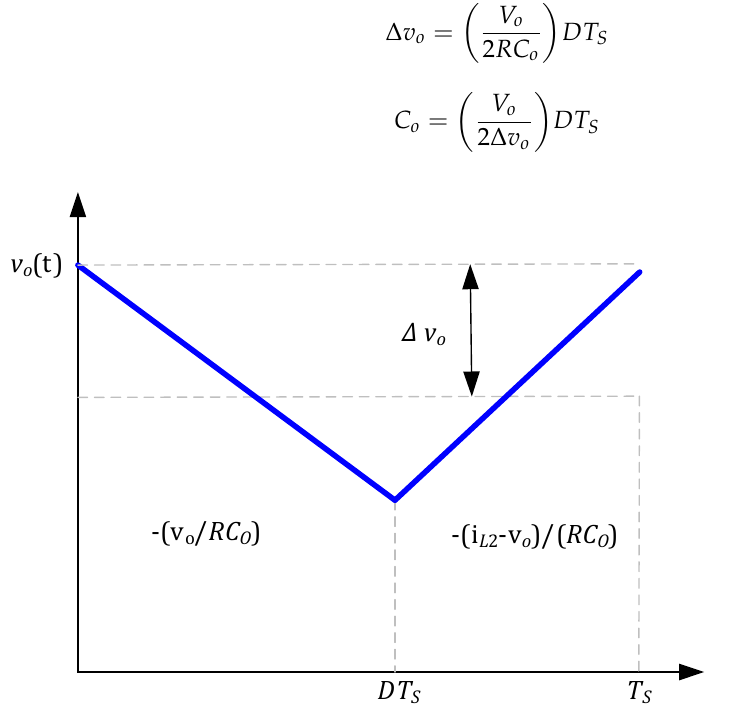
Figure 9. The capacitor C o output Figure 9. the capacitor C o output voltage.